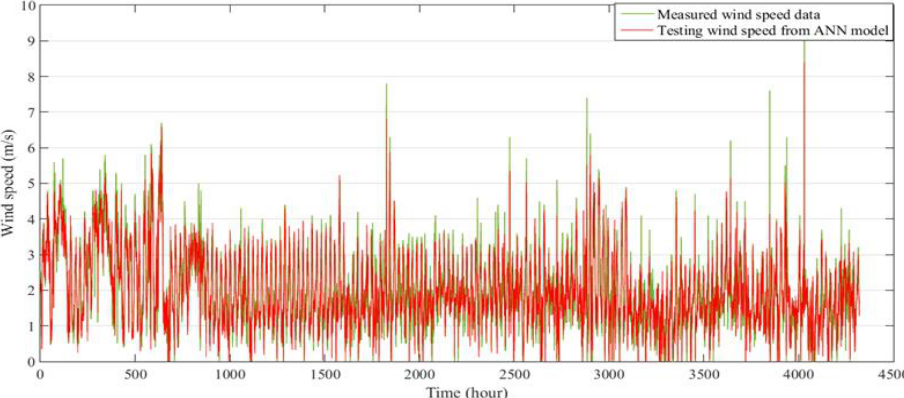
Figure 16. Comparison between measured and predicted hourly wind speed data for six months at Kuala Terengganu, for validation of the ANN model.